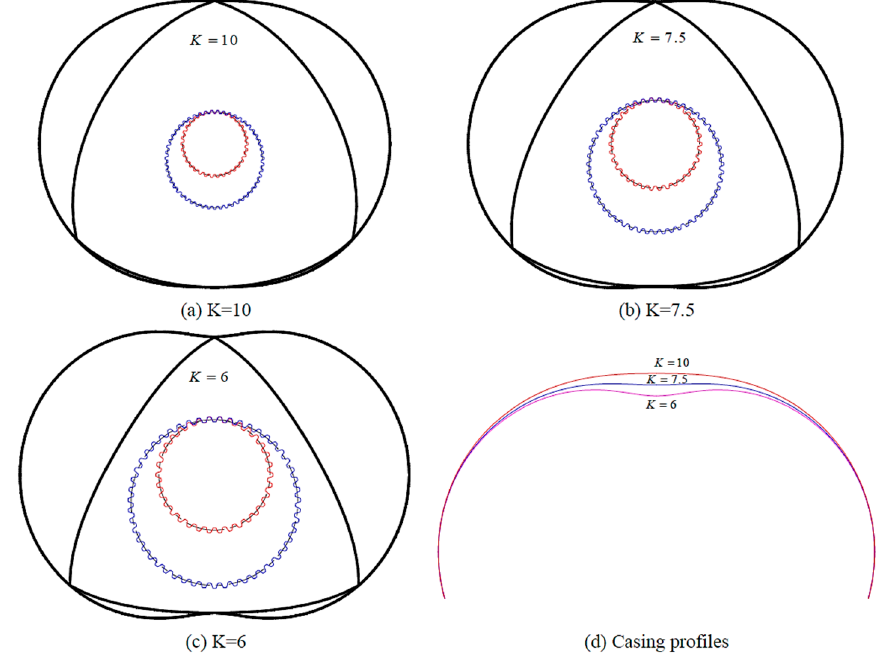
Figure 12. Design results of K factor for the rotary engine (Hsieh and Cheng [85]). Bhoir and Tambuskar, using CFD methods, revealed that the deviation function approach for epitrochoidal engine design is instrumental to generate several profiles from noncircular pitch curves without using higher order nonlinear equations. Noncircular pitch designs can improve the chamber shape, the apex sealing, or the thermodynamic phase timing at varying speed ratios. By adjusting the pitch curves, varying the speed ratios between the rotor and main shaft can change the velocities of the apex seals. Thus the DF-designed profiles allow more design flexibility and enable variable speed ratios [86]. Hsieh, in a recent study, has proposed chamber profiles and triangular rotor profiles in an RE. Using the epitrochoid and envelope concepts for the dynamic analysis of the kinematics and stresses at the apex seals, it was found that a higher trochoid ratio de- creases system stability and raises vibrations, stress variations, and stress intensity. When taking into account combustion chamber displacement, compression ratio, operation sta- bility, and parts load capacity, the trochoid ratio of 0.4 is recommended [87]. The theoret- ical profile design results for various trochoid ratios are presented in Figure 13. Figure 13(a,b,c) shows the sun gear constructed from the theoretical rolling circle shown in blue and the fixed circle shown in red for trochoid ratio λ =0.3, 0.4 and 0.5 respectively. Figure 13(d) shows the sun gear constructed from the theoretical profile for trochoid ratio λ =0.6, which means the internal gears are not feasible and thus for production the trochoid ratio is proposed to be less than 0.6. Figure 1(e) presents design of housing and rotor profile for three different trochoid ratios. The large, medium and small trochoid ratios ( λ =0.5, 0.4, and 0.3) are shown in pink, blue and red color respectively.